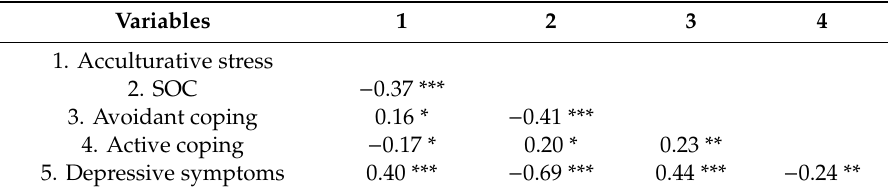
Table 4. Pearson’s correlations between the study